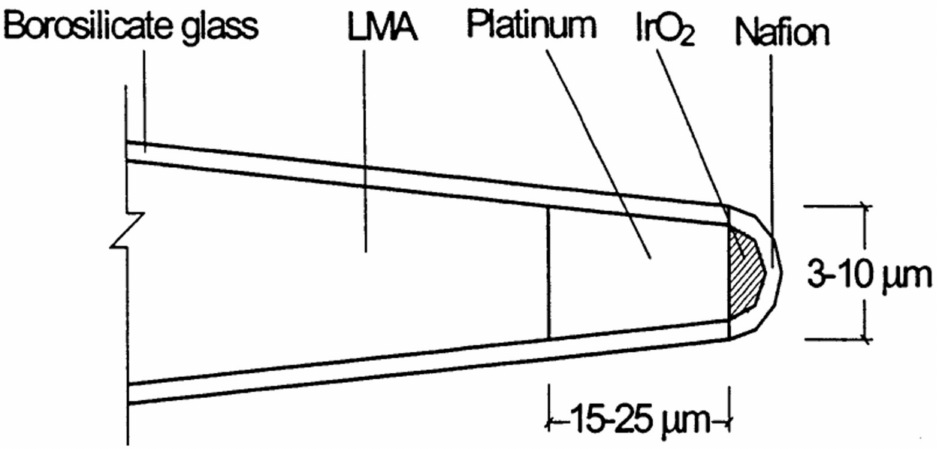
Figure 10. Schematic of the tip of an AEIROF microelectrode. The diagram is not to scale. Reprinted from the permission of reference [55]. Copyright 2002 American Chemical